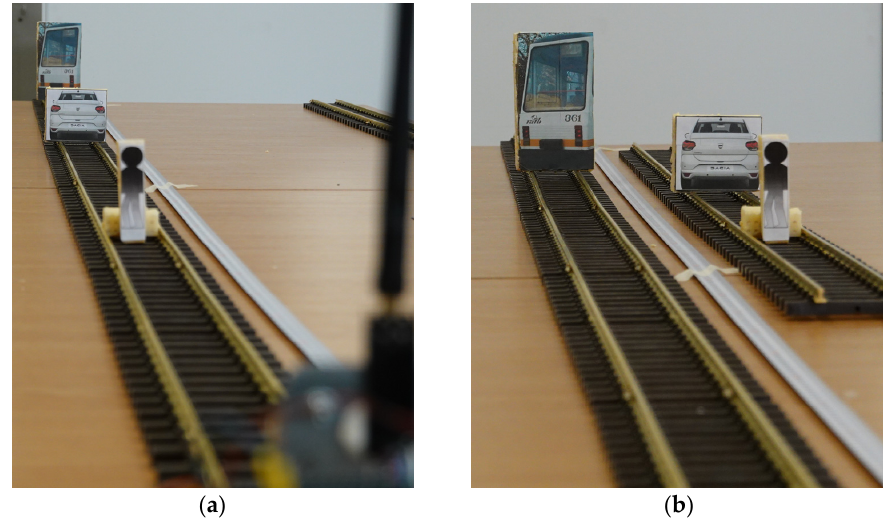
Figure 8. Fake targets used for indoor testing of long-range LiDAR.: ( a ) pedestrian model and/or car model placed between the tram equipped with sensor and the tram target; ( b ) pedestrian model and/or car model placed on the lateral line from the tram equipped with sensor and the tram target.